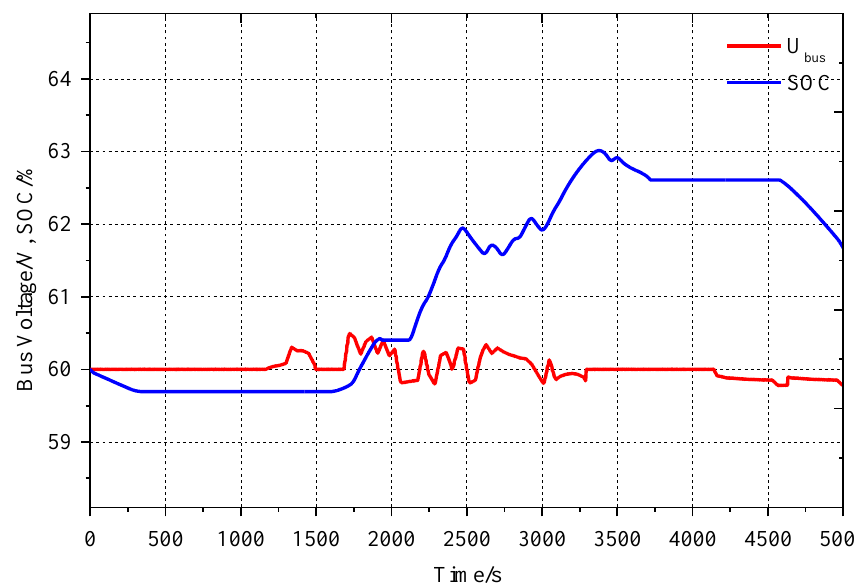
Figure 12. The bus voltage and SOC of the battery bank in Case II.